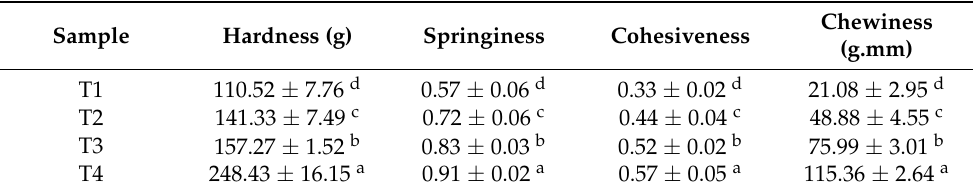
Table 1. The texture properties of the PSE meat myofibrillar protein gels with varying amounts of added sodium bicarbonate.